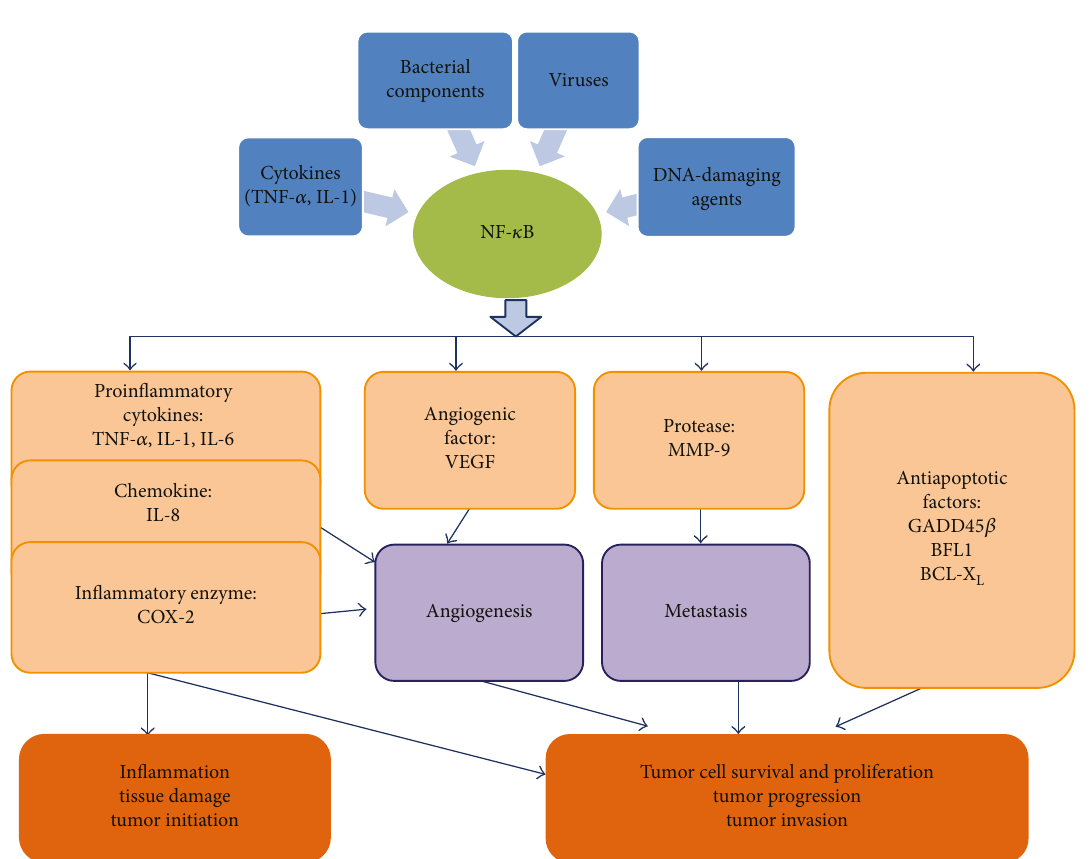
Figure 1: NF- κ B pathway functions as the molecular link between in fl ammation and tumorigenesis. NF- κ B pathway can be activated by proin fl ammatory cytokines (TNF- α and IL-1), bacterial components (such as LPS), viruses, and DNA-damaging agents. Activation of NF- κ B pathway induces expression of proin fl ammatory cytokines (such as TNF- α , IL-1, and IL-6), chemokines (IL-8), and enzymes (COX-2) that contribute to in fl ammation-related tissue damages and are associated with tumor initiation. Antiapoptotic factors GADD45 β , BFL1, and BCL-X ensure tumor cell survival and proliferation. In addition, VEGF, COX-2, and IL-8 promote angiogenesis and play an L important role in tumor progression. MMP-9 contributes to tumor progression through facilitating